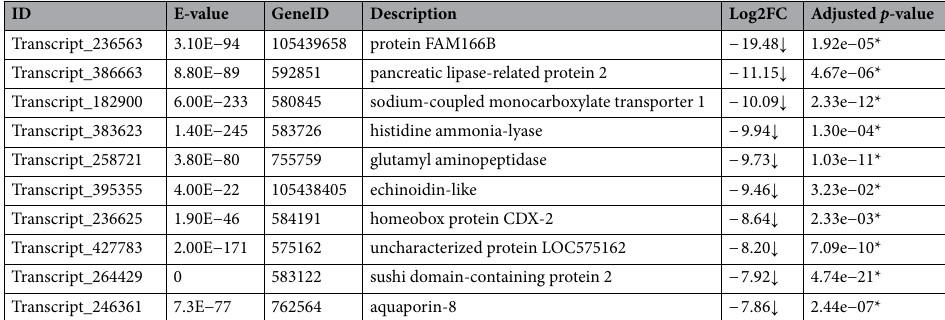
Table 2. Top 10 downregulated DEGs at day 1 of regeneration. ↓ : Downregulated (Log2FC < − 2); *: Significant ( p value < 0.01); Log2FC: Log 2 Fold Change.